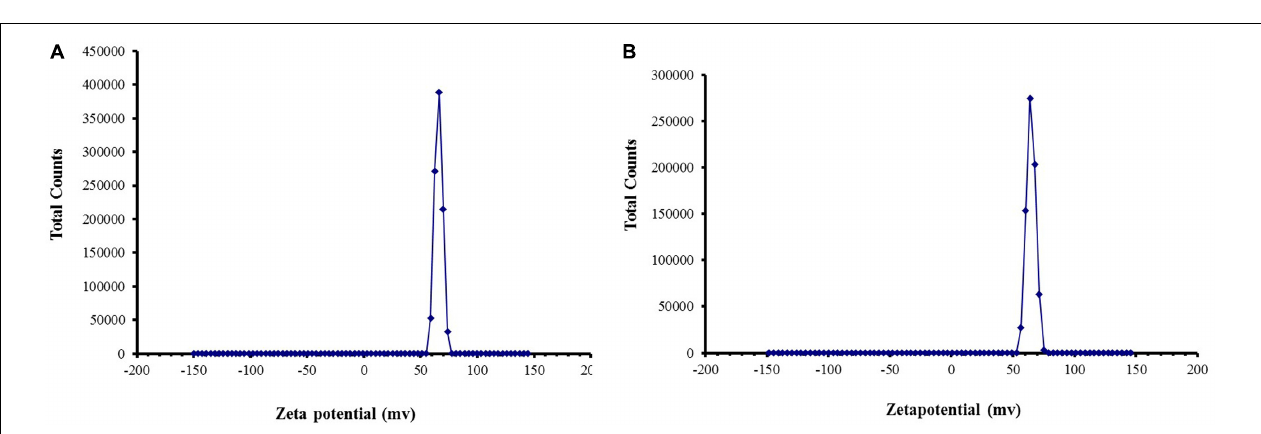
FIGURE 4 | Zeta Potential of (A) blank CSNPs and (B) cardamom oil-loaded CSNPs. Zeta potential was measured through Malvern Instrument. A positive zeta potential of more than 50 mV was observed for both blank and EOs loaded